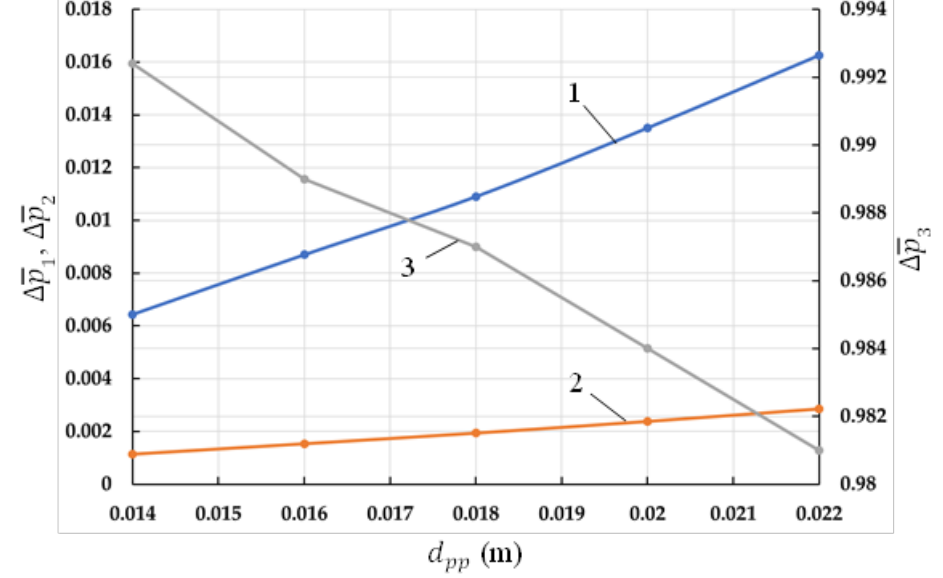
Figure 13. Dependence of relative pressure loss ∆ p line (1- ∆𝑝 ; 2- ∆𝑝 ; 3- ∆𝑝 ). 1 2 3